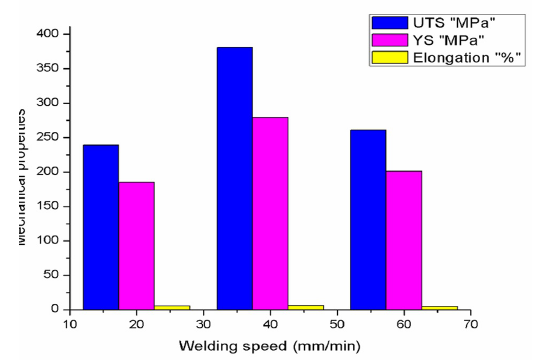
Figure 9: Effect of welding speed on tensile strength